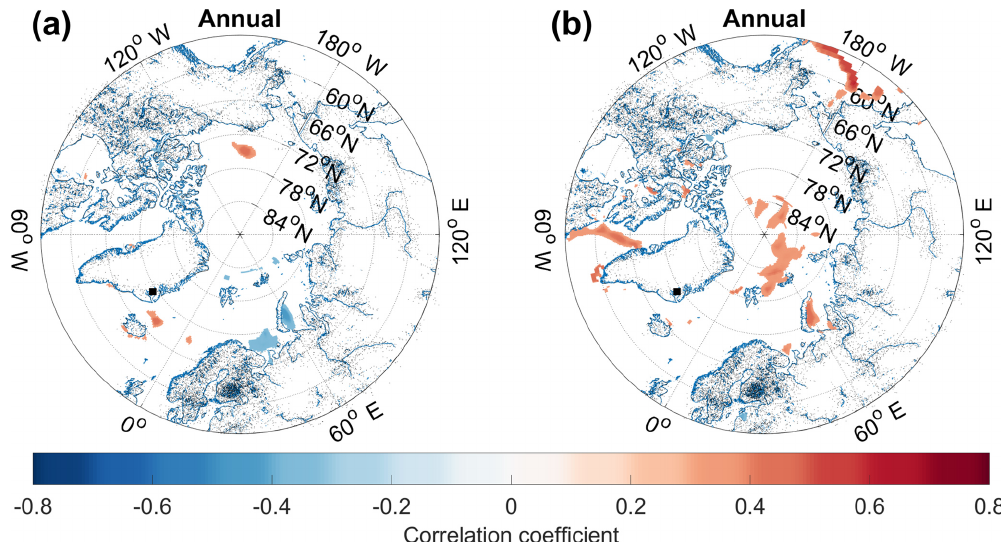
Figure 14. Maps showing the d xs -SST (a) and d xs -SIC correlation coefficients between annually averaged data from RECAP and ERA- Interim covering the 1980–2014 period ( p < 0 .